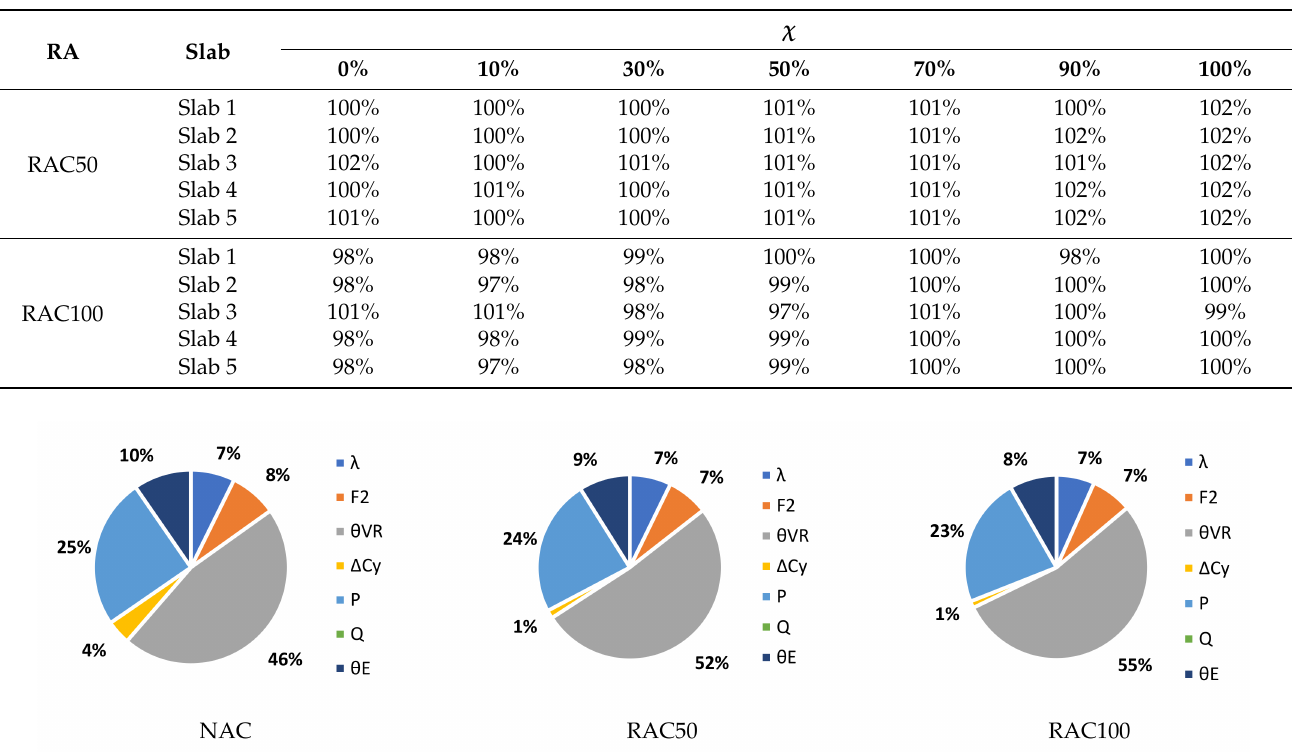
Figure 7. α 2 for χ = 0 and Slab 1. Slabs without shear reinforcement. EN1992 [31]. γ NAC = 1.45 and γ CRAC 50 = 1.55, γ RAC 100 = 1.60 (no calibration needed).